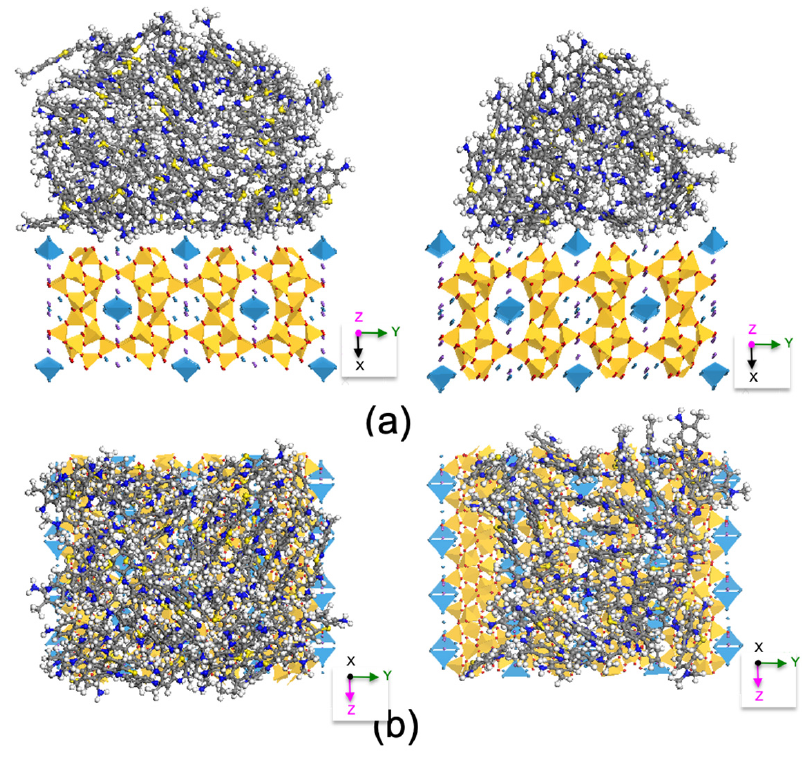
Figure 8. Molecular dynamic simulation showing TB uptake ( left ) and TB + SO ( right ) on the {100} surface projected along crystallographic c ( a ) and a ( b ) directions of ZEO.